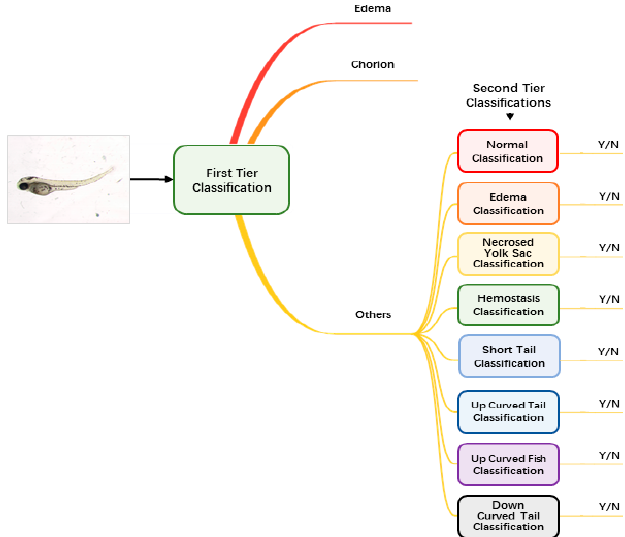
Figure 2. The pipeline of the two-tier classification strategy.